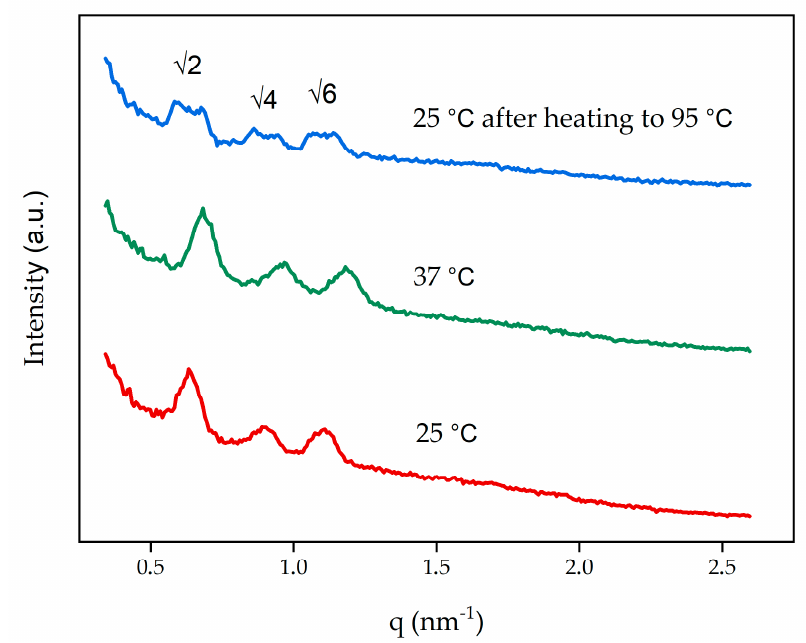
Figure 2. Small-angle X-ray scattering (SAXS) diffraction patterns obtained for non-doped cubosomes at 25 °C, 37 °C, and 25 °C following equilibration after heating to 95 °C. Table 2. SAXS properties of the cubosomes obtained at different temperatures. Cubosomes Formulations